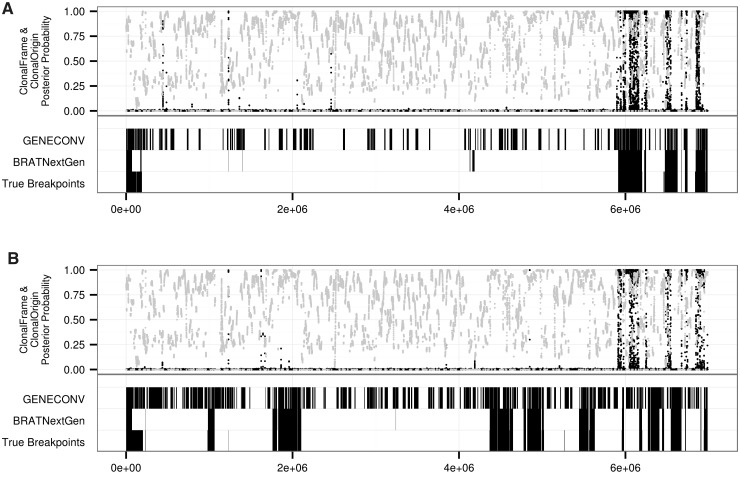
Results of detection methods on known transconjugants. Recombination breakpoints from BRATNextGen and GENECONV and posterior probability of recombination from ClonalFrame (black dots) and ClonalOrigin (gray dots) are shown for M. smegmatis transconjugants, Km6.9a (A) and Km4.5a (B). True breakpoints for recombinant tracts in Km6.9a and Km4.5a are from Gray et al. (2013). BRATNextGen performed best at identifying recombinant regions transferred through DCT in M. smegmatis.